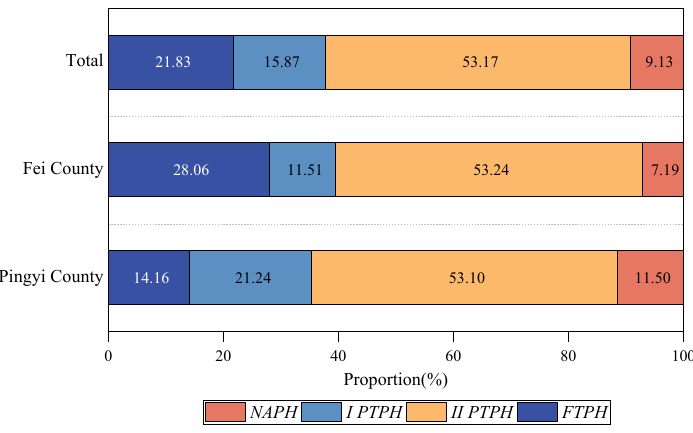
Figure 2. Results of the classification of peasant household types.